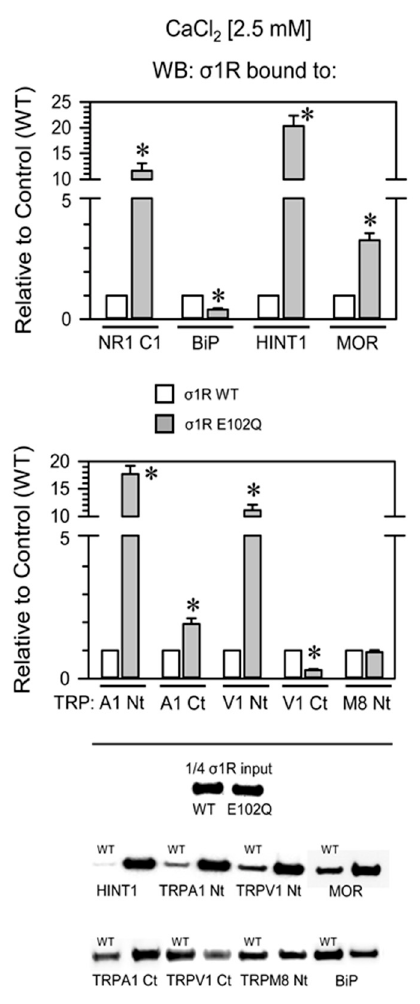
Figure 4. Binding of WT σ 1R and σ 1R E102Q to proteins that regulate NMDAR function and to the cytosolic domains of TRPA1, TRPV1, and TRPM8. Recombinant cytosolic C0-C1-C2 region of the NMDAR NR1 subunit, the C-terminal cytosolic region of MOR, the HINT1 protein, BiP, and the N- and C-terminal cytosolic domains of TRPA1, TRPV1, and TRPM8 channels were covalently attached to agarose and incubated with human WT σ 1R or its mutant in the presence of 2.5 mM CaCl 2 (details as in Figure 2). The assays were repeated at least twice, and comparable results were obtained. Representative blots are shown. For each interaction between σ 1R WT or the σ 1R E102Q mutant and a given protein, * indicates a significant di ff erence compared to the σ 1R WT group (assigned an arbitrary value of 1); all data were analyzed by ANOVA followed by the pairwise Holm–Sidak multiple comparison test; p < 0.05; σ 1R, sigma receptor type 1; NR1-C1, cytosolic region the C0-C1-C2 domains of the NR1 subunit of NMDARs; BiP, binding immunoglobulin protein; HINT1, histidine triad nucleotide binding protein 1; MOR, mu-opioid receptor; TRP, cytosolic transient receptor potential types A1, V1, and M8; Ct, C-terminal domain; Nt, cytosolic N-terminal domain; WT,